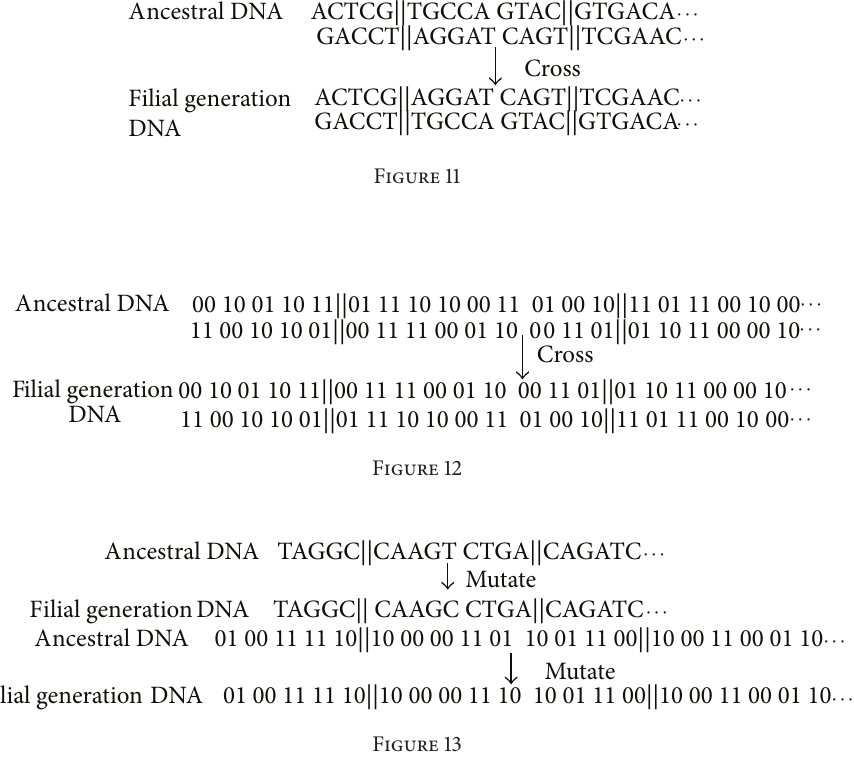
Figure 9 is the distribution path of DNA-ant colony under moderate or high level pollution condition. The processes